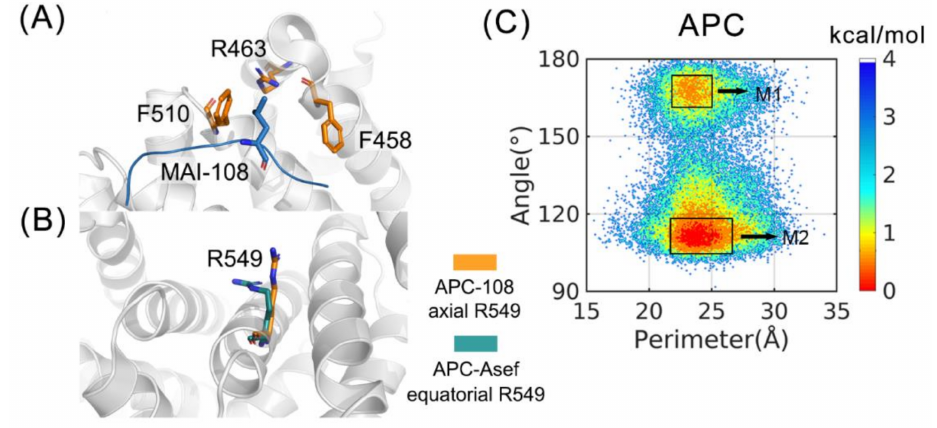
Figure 2. Free energy landscape of APC and corresponding parameters. ( A ) The hydrophobic pocket in the APC-108 structure. F510, R463, F458, and L185 are shown in sticks. ( B ) Different R549 in APC-108 and APC-Asef crystal structures. ( C ) The free energy landscape of APC. Different major conformations are labeled as M1 and M2. x coordinates are the perimeter of the triangle formed by the C α of the hydrophobic pocket F510, R463, and F458, while y coordinates are the angle formed by the guanidino carbon, C γ , and C α of R549. See part 4.3 for